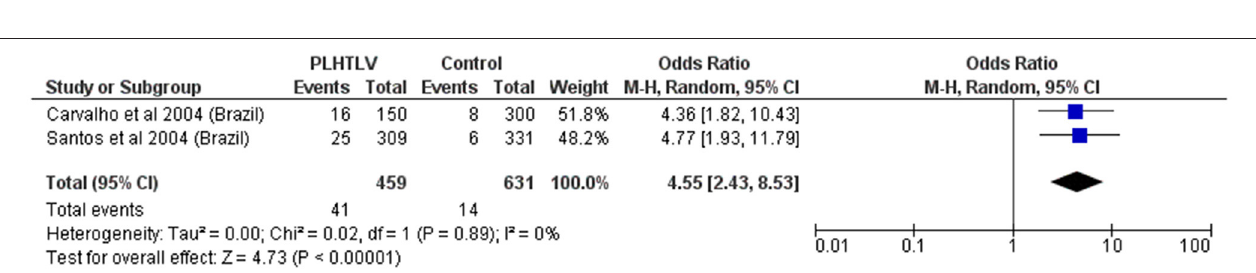
revealed an association between HTLV-1 and lower